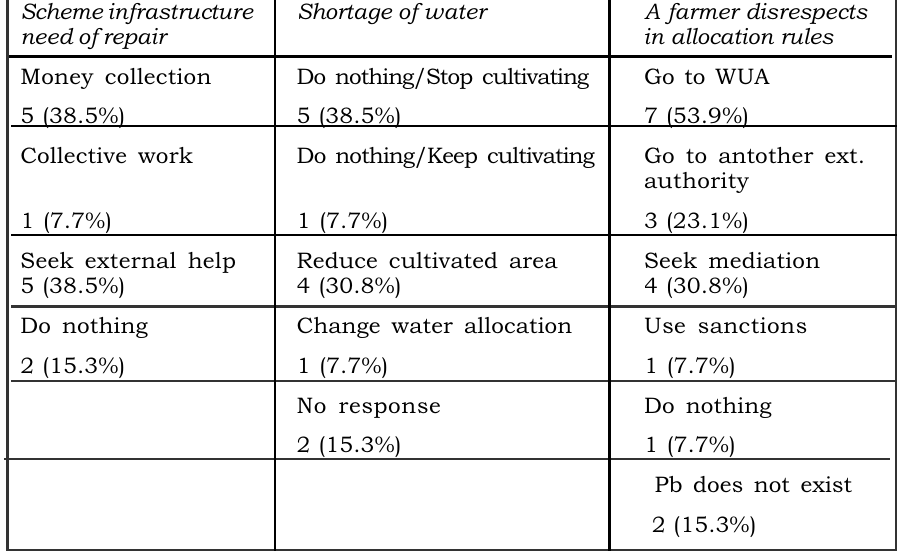
Table 4 Reponses to practical scenarios (nb and % of respondents 1